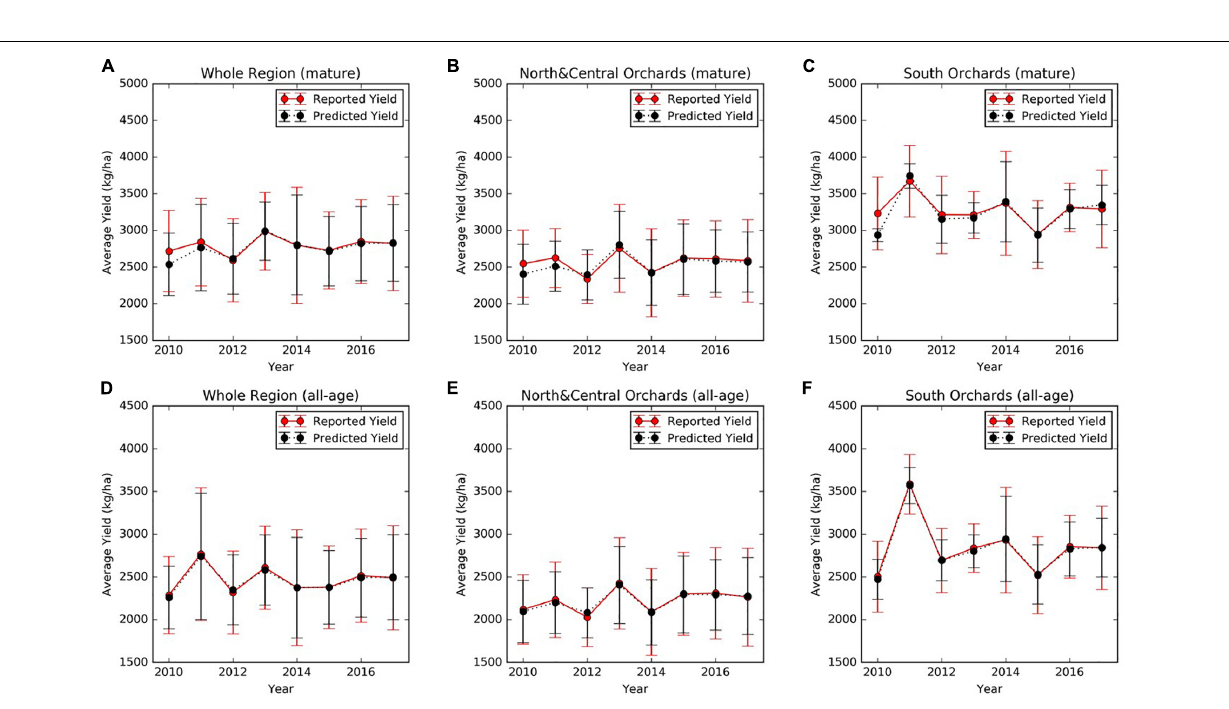
FIGURE 5 | Mean annual reported almond yield and early-season predictions averaged (A) over mature (7–17 years old) orchards and (D) over all orchards within the study area. Similar results were presented here for (B,E) orchards in the northern and central region and (C,F) for southern orchards, respectively. The vertical lines represented the standard deviation among